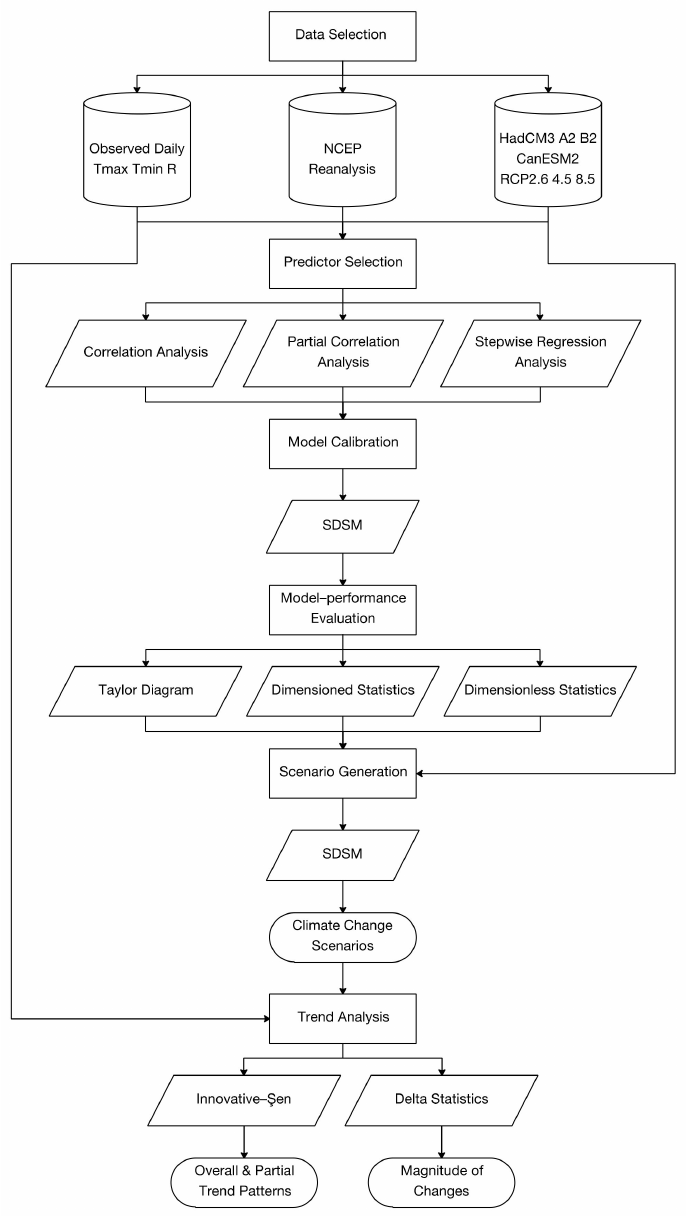
Figure 2. Schematic framework of research